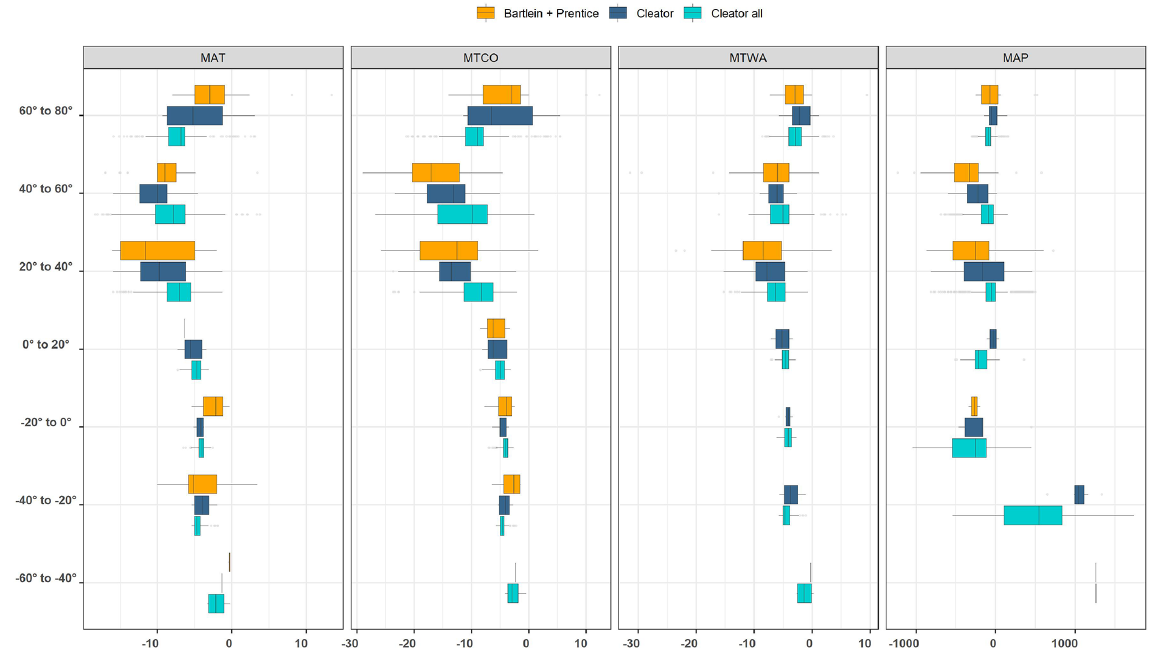
Figure 9. Comparison of terrestrial climate variables from the combined Bartlein et al. (2011) and Prentice et al. (2017) dataset and from the Cleator et al. (2020) reconstruction using data assimilation, averaged over 20 ◦ latitudinal bands. The variables are mean annual temperature (MAT), mean temperature of the coldest month (MTCO), mean temperature of the warmest month (MTWA) and mean annual precipitation (MAP). The orange boxplots show the results from the Bartlein et al. (2011) and Prentice et al. (2017) combined dataset, the dark blue boxplots for the reconstructions by Cleator et al. (2020) at sites for which there are reconstructions in the combined dataset, and the green boxplots show the results for the full reconstructions from Cleator et al.